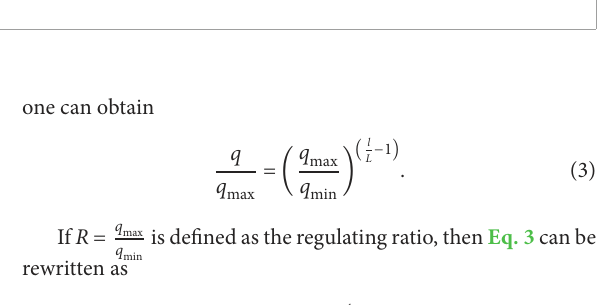
FIGURE 2 Control structure of the fan-coil.